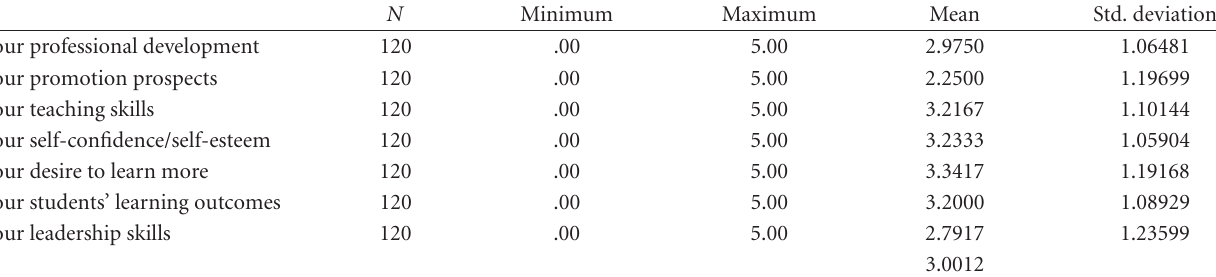
Table 8: Teachers’ satisfaction with PD over the last 5